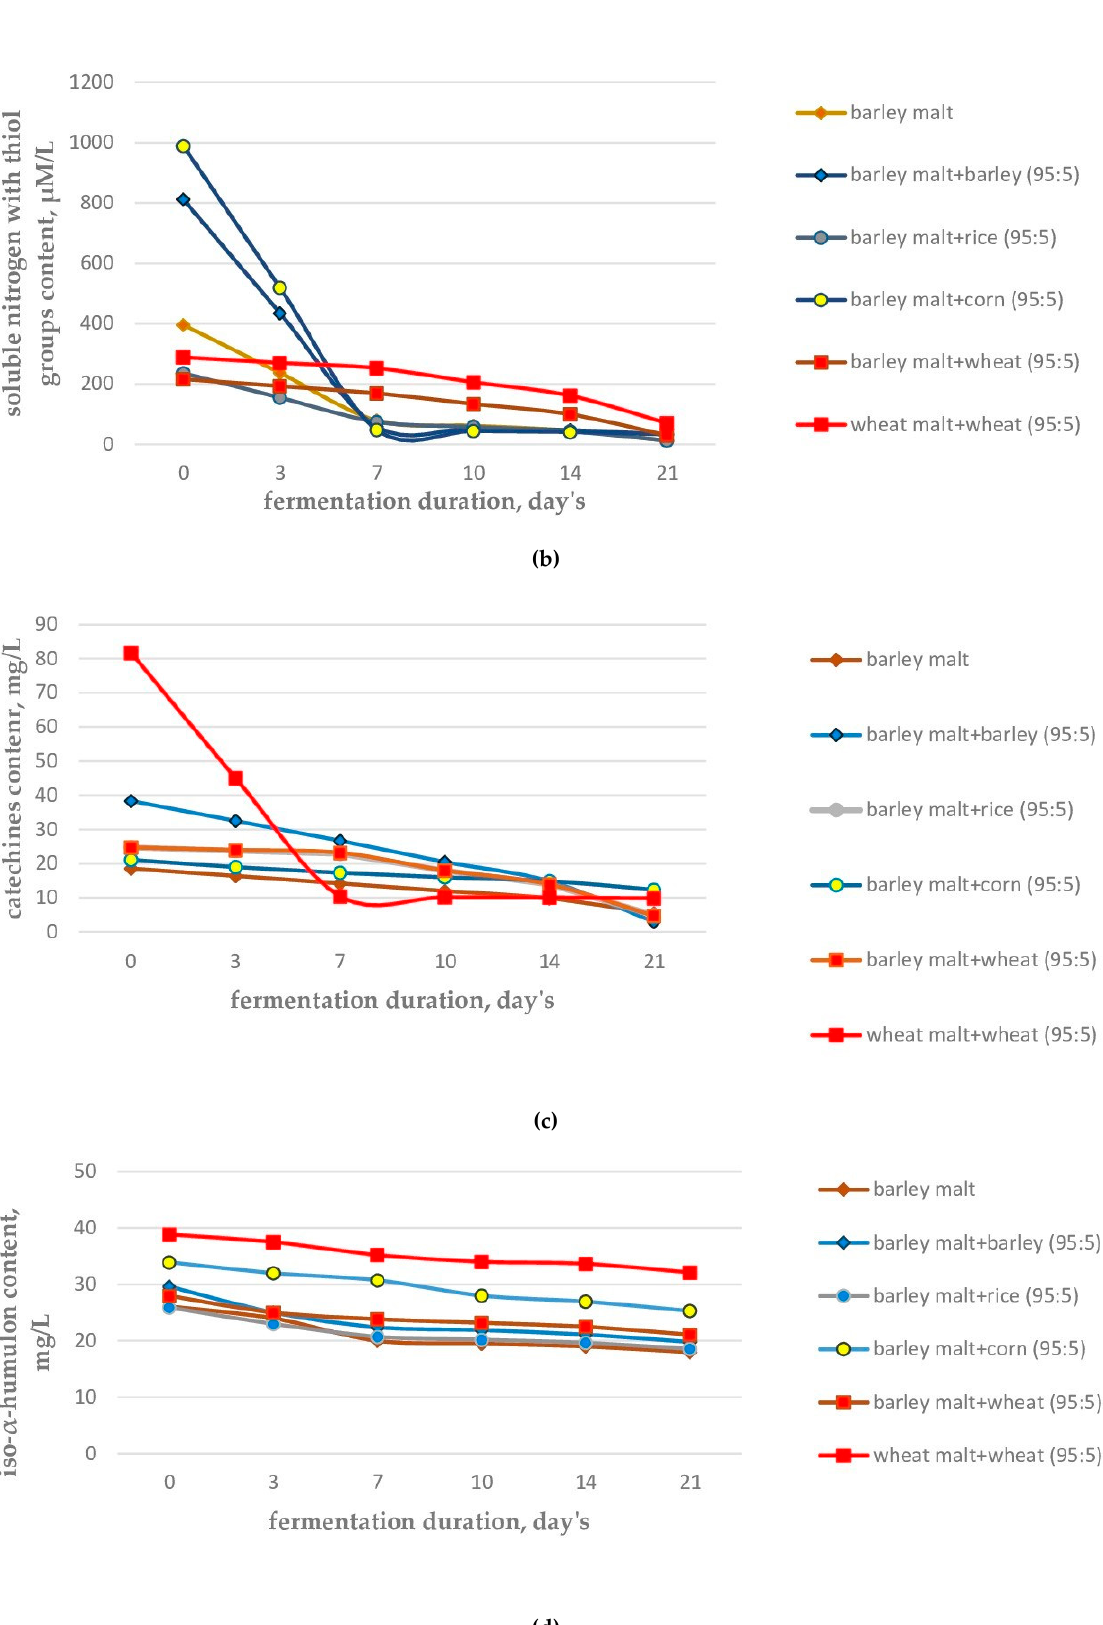
(e) Figure 1. The content of β -glucan ( a ), soluble nitrogen compounds with thiol groups ( b ), catechins ( c ) and iso- α -humulone ( d ), quercetin ( e ), changes in dynamics during wort sample fermentation of different adjuncts. The change in the content of β -glucan (Figure 1a) occurs most significantly for a total of three times in fermented wort from wheat malt + wheat, since the formation of colloidal particles consisting of nitrogenous, phenolic, and non-starch carbohydrate compounds occurs, which are sufficiently high in molecular weight to remain in equilibrium in the dispersed structure [66]. The decrease in the concentration of non-starch polysaccharide is more linear in the other cases with a decrease in β -glucan content observed by 1.1 – 2 times. Moreover, we can arrange the options of cereal composition in the following order by a decrease in β - glucan content during fermentation: Wheat malt + wheat → barley malt + rice → barley malt + barley → barley malt + corn → barley malt fermented wort samples. On the one hand, a lower β -glucan concentration indicates a more dissolved structure of the cereal components and a lower molecular weight of the non-starch polysaccharide inherent in the fermented wort; on the other hand, this is indicated by the type of structure [67,68]. Changes in soluble nitrogen (peptones) with thiol groups (Figure 1b) show interest- ing dynamics and divisions of samples into groups. Based on the changes in nitrogen compounds, natural barley malt + corn, barley malt + barley, barley malt + rice beer